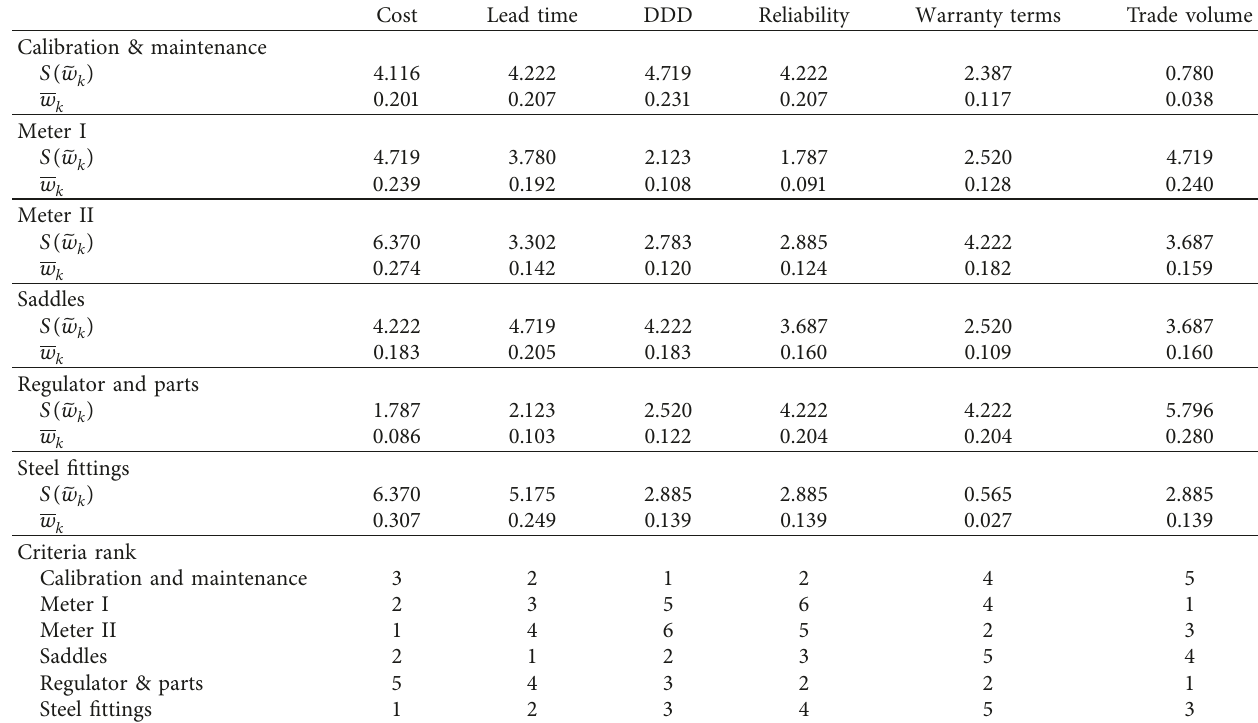
Table 10: S ( 􏽥 w w k ), k and final criteria weight results corresponding varying item groups.